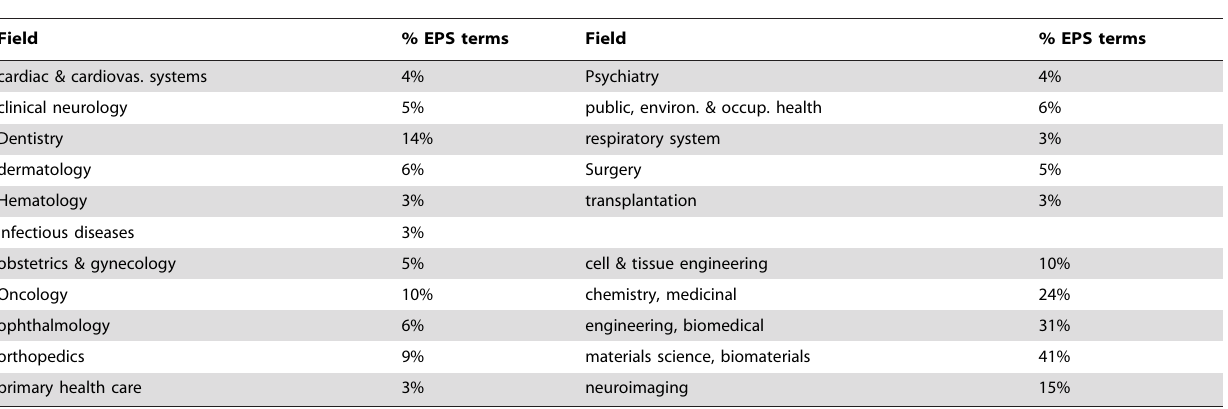
Table 3. Percentage of EPS-related terms per field.